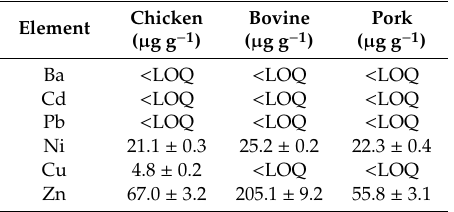
Table 4. Results of the analysis of meat samples from local shops.